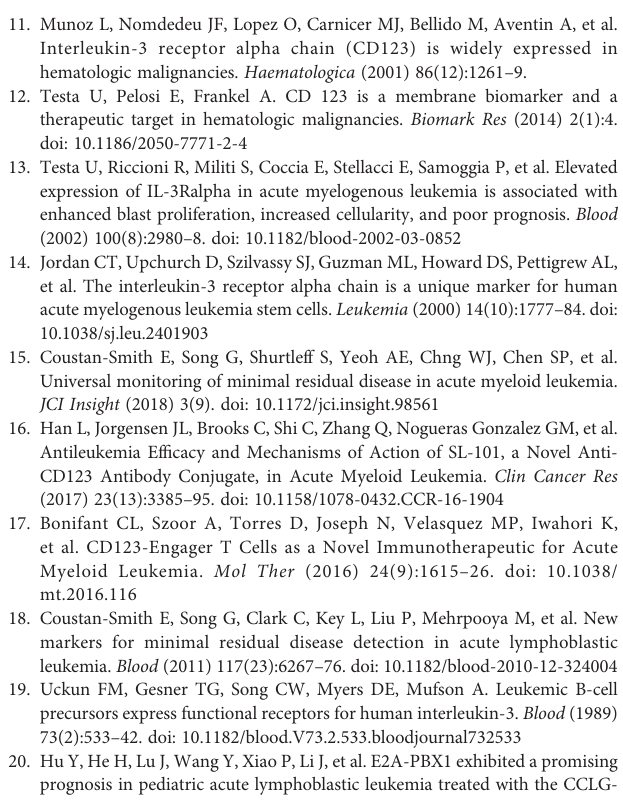
Supplementary Figure 1 | CD123 expression in pediatric B-ALL patients from the CCLG-2008 and CCCL-2015 cohorts. (A) The plot of CD123 expression on leukemic blasts in pediatric B-ALL patients from the CCLG-2008 and CCCL-2015 cohorts. (B) The detailed statistical description of CD123 expression in both cohorts. Supplementary Figure 2 | Pediatric B-ALL with favorable clinical outcomes displayed a high CD123 expression in the CCCL-2015 cohort. Comparison of CD123 expression on leukemic blasts between survivors and non-survivors (A) , event-free and with-event patients (events including drug resistance, treatment abandonment, relapse, and HSCT) during treatment (B) , and relapsed or non- relapsed B-ALL (C) in the CCCG-ALL-2015 cohort; (D) Detailed amounts of patients and mean CD123 percentage in each group from A-C. **, p<0.01. Supplementary Figure 3 | High CD123 expression correlates with favorable clinical outcomes of pediatric B-ALL treated with CCCG-ALL-2015 protocol. Comparison of OS (A) , EFS (B) , and RFS (C) among CD123high, CD123low, and CD123neggroupsintheCCCG-ALL-2015cohort;(D)Thedetailednumberofevent occurrences and cases under observation in the CD123high, CD123low, and CD123neg groups in every follow-up year. Estimated 5-year survival rates in each group were calculated; Comparison of OS (E) , EFS (F) , and RFS (G) between patients with over or less than 50% blasts expressing CD123; Comparison of OS (H) , EFS (I) , and RFS (J) between patients positively- or negatively expressing CD123. Supplementary Figure 4 | High CD123 expression conferred favorable clinical outcomes in pediatric B-ALL without prognosis-de fi ning genomic abnormalities in the CCCG-ALL-2015 cohort. Kaplan-Meier analysis of overall OS (A) , EFS (B) , and RFS (C) across patients withdifferent genetic abnormalities in the CCCG-ALL-2015 cohort; Comparison of OS (D), EFS (E), and RFS (F) according to the CD123 expression among patients without prognosis-de fi ning genetic aberrations in the CCCG-ALL-2015